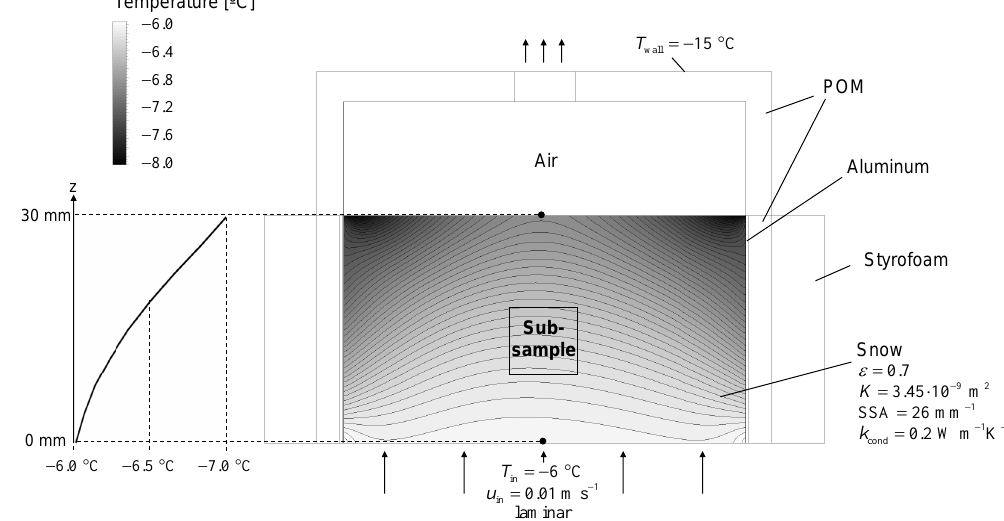
Figure 4. Cross section of the 3-D thermal simulation of the temperature gradient inside the snow sample. Only the snow sample and the device cover were considered to reduce the complexity of the simulation.